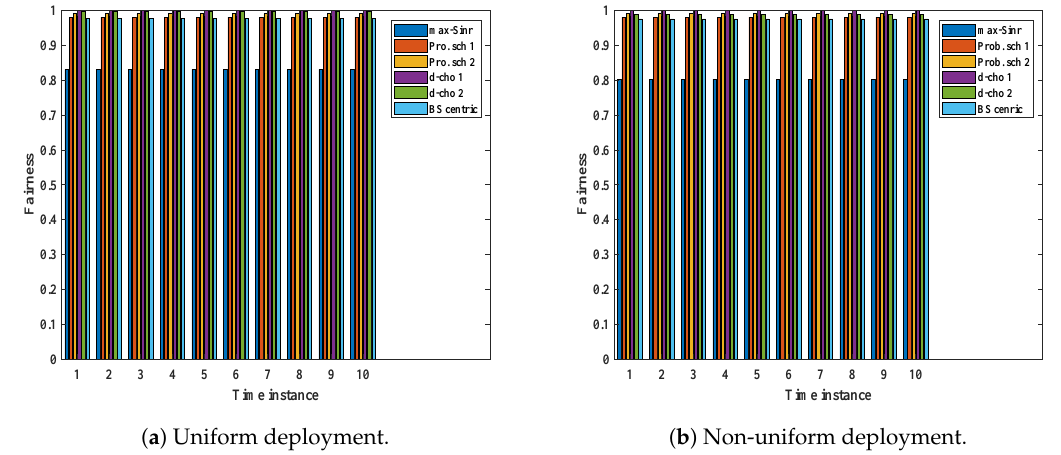
( b ) Non-uniform deployment. Figure 11. Jain’s fairness for different association schemes in different deployment